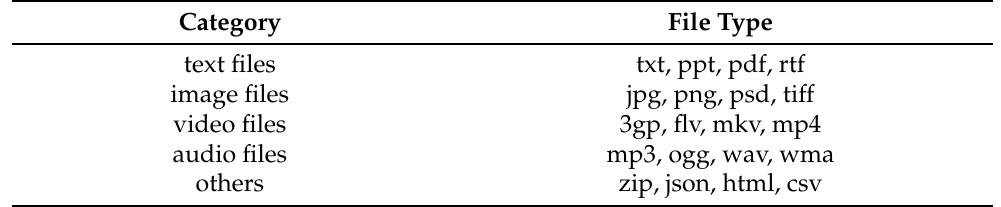
Table 4. The file types tested for data